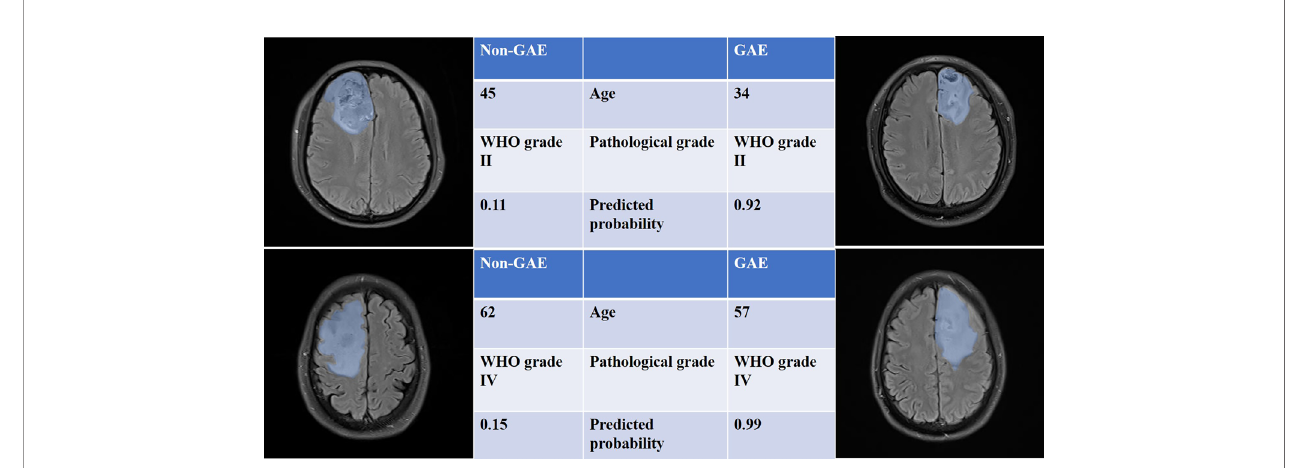
FIGURE 4 | T2 FLAIR images of four patients with or without GAE experience. The blue shadow in the images was manually delineated as the region of VOI. All the clinical characteristics and predicted probabilities of the combined model are presented at the center of the